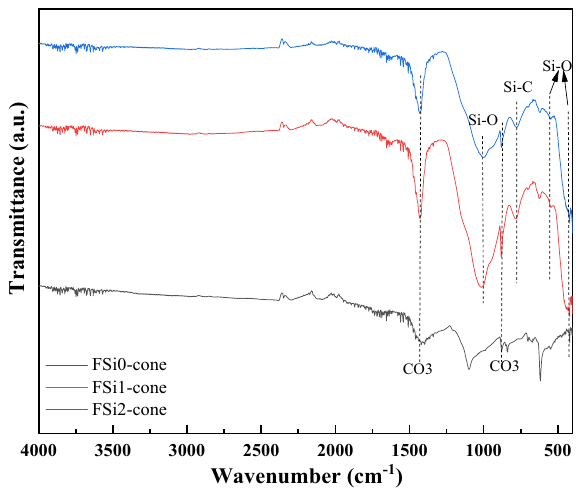
Figure 16. The FTIR results of samples in the FSi group subjected to fire.